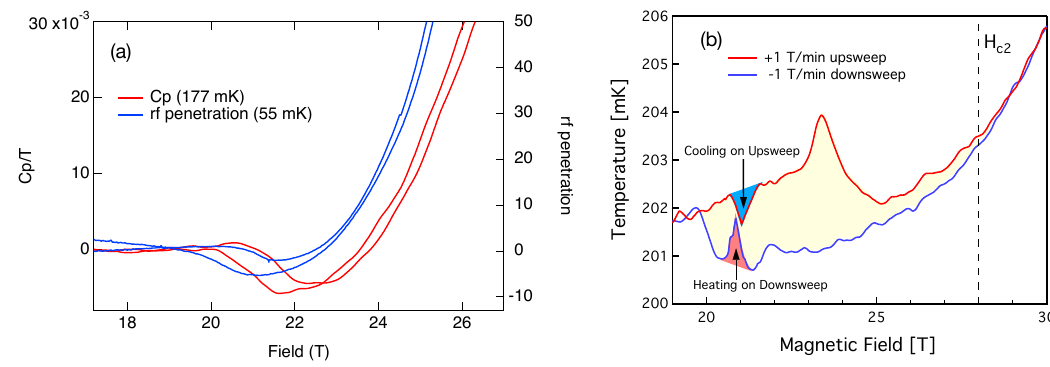
Figure 5. Color online. ( a ) specific heat and TDO up and down field traces as the measurements cross the vortex-FFLO phase transition showing the hysteresis. This is direct evidence of a first order transition; ( b ) from Agosta et al. [3], the magneto caloric effect, which shows the direction of the flow of latent heat as the vortex-FFLO phase line is crossed. This information can be used to show that the higher field state, in this case the FFLO state, is of higher entropy than the vortex state, consistent with what is expected for this phase transition [3,94,95].